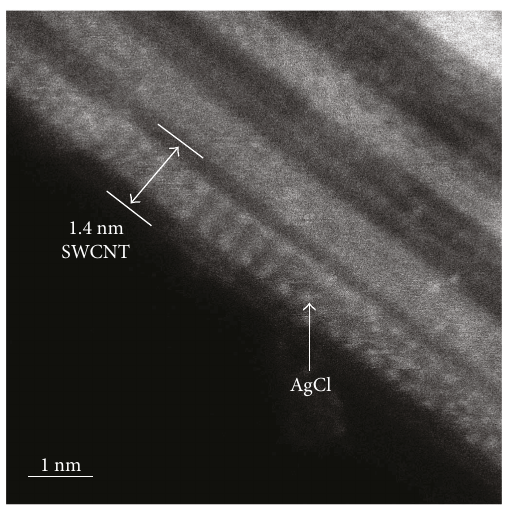
Figure 1: The HR STEM microphotograph of AgCl- fi lled